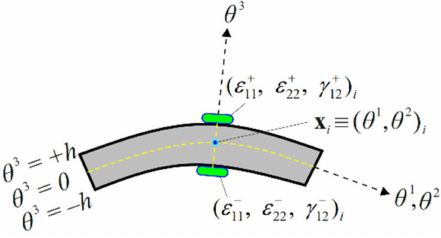
Figure 3. Discrete surface strains measured at ( x i , ± h ) ( i = 1,2, ... , n s )